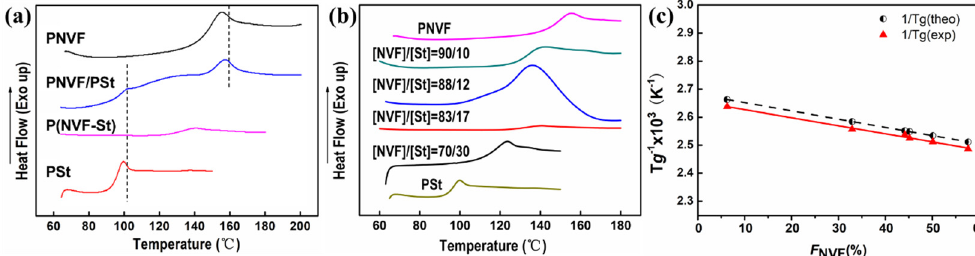
Figure 2. DSC curves of ( a ) PNVF/PSt blend (mass ratio 1/1) and ( b ) NVF-St copolymers. ( c ) The relationship between T g and NVF unit content in NVF-St copolymers. Solid triangle dot: T g obtained by DSC measurement; cycle dot: T g calculated based on the composition using Fox equation.